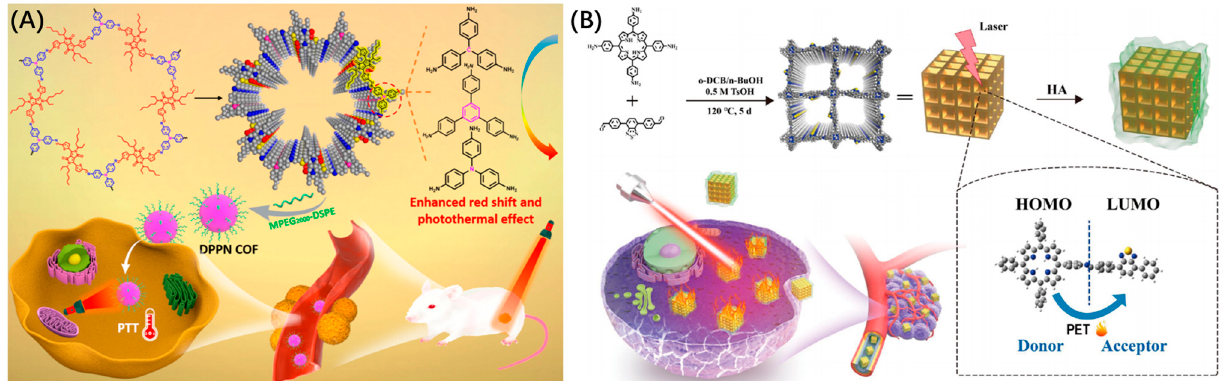
Figure 8. ( A ) Schematic synthesis of D-A structured COFs. ( B ) Schematic design and preparation of TB-COF-HA for PTT. Reprinted with permission from [78]. Copyright 2021 American Chemical Society. Reprinted with permission from [79]. Copyright 2022 Springer Nature.